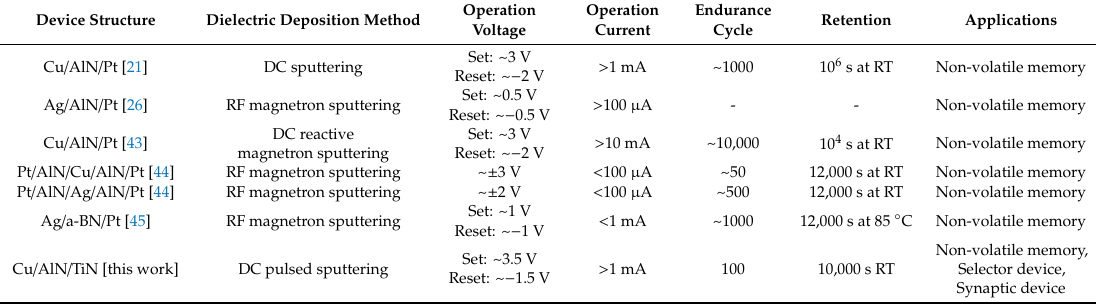
Table 1. Comparison of the resistive switching performances among nitride-based CBRAM